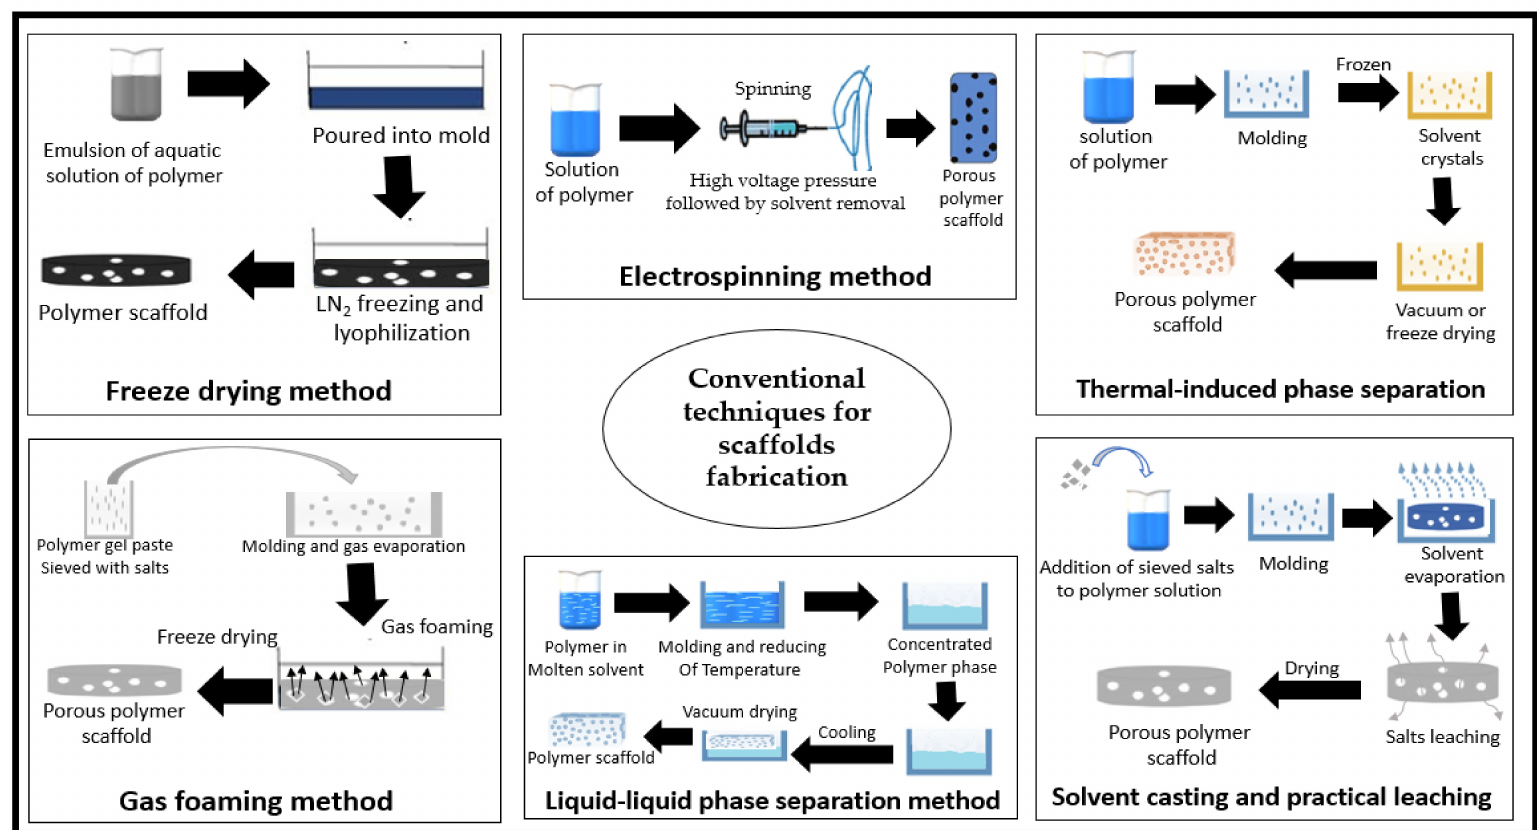
Figure 6. Schematic drawing of the biopolymer forming process of conventional techniques for sca ff old